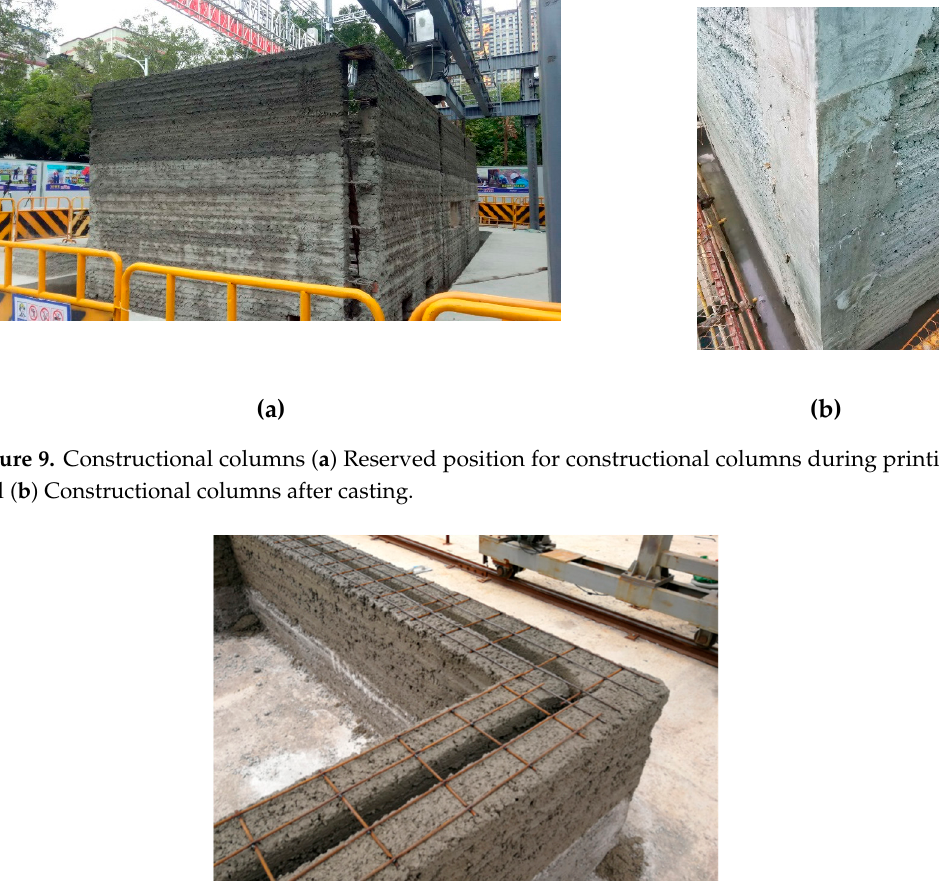
Figure 10. Horizontal steel mesh.